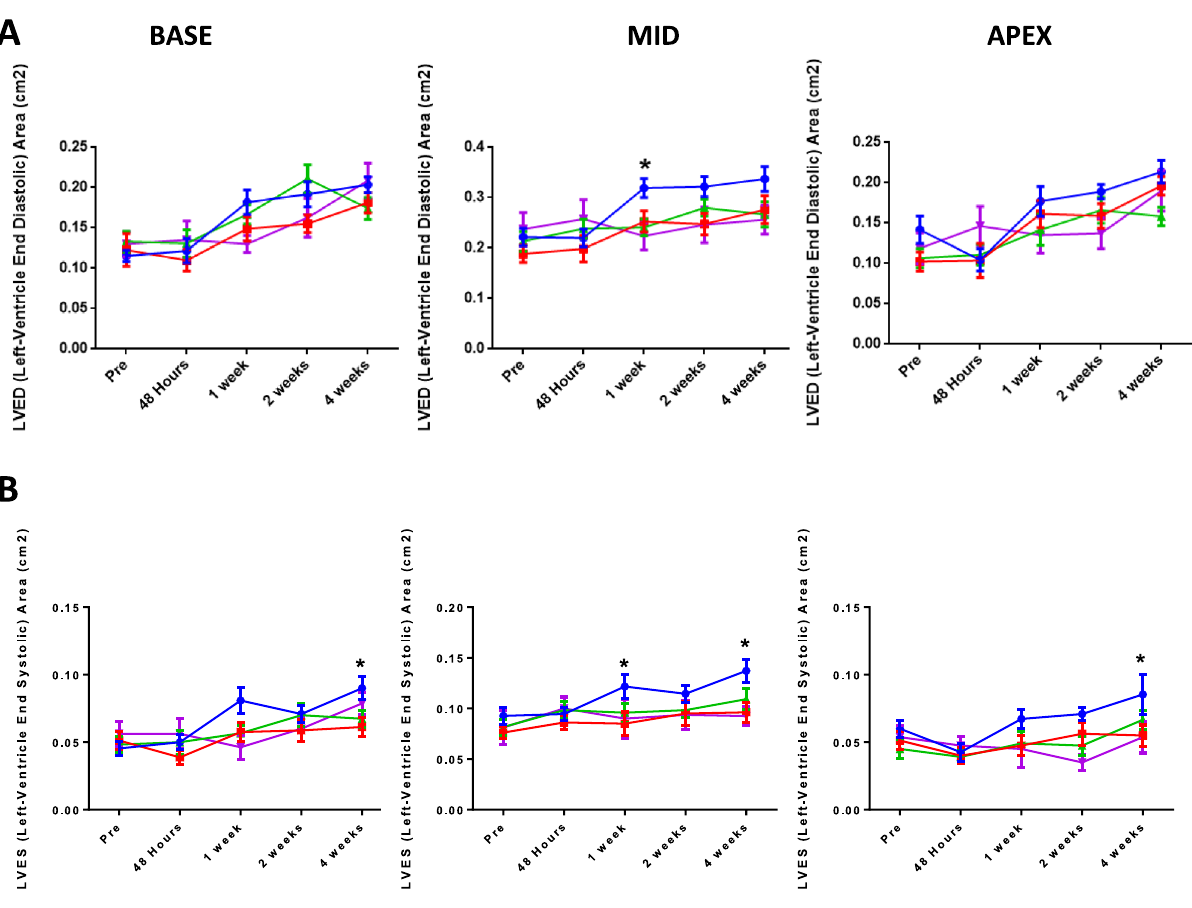
Figure 4. (A) Left-ventricle end diastolic area over (left to right) the base, mid and apex sections from pre- surgery to 4 weeks post-surgery for the 4 experimental groups. Red lines and symbols: vehicle/sham group; blue lines and symbols: vehicle/IR group; pink lines and symbols: SCN − /sham group; green line and symbols: SCN − /IR group. Statistical analysis using two-way ANOVA and Dunnett’s Multiple Comparison Test, showed a significant difference in the mid-section for the vehicle /IR group compared to the other groups at 1 week, where * indicates p < 0.05. (B) Left-ventricle end systolic area over (left to right) the base, mid and apex sections from pre-surgery to 4 weeks post-surgery. Colour coding as panel ( A) . Statistical analysis using two-way ANOVA and Dunnett’s Multiple Comparison Test, showed statistically-significant differences in the vehicle/IR group compared to the other groups at 4 weeks in the base section, 2 and 4 weeks in the mid-section, and at 4 weeks in the apex section, with * indicating p <